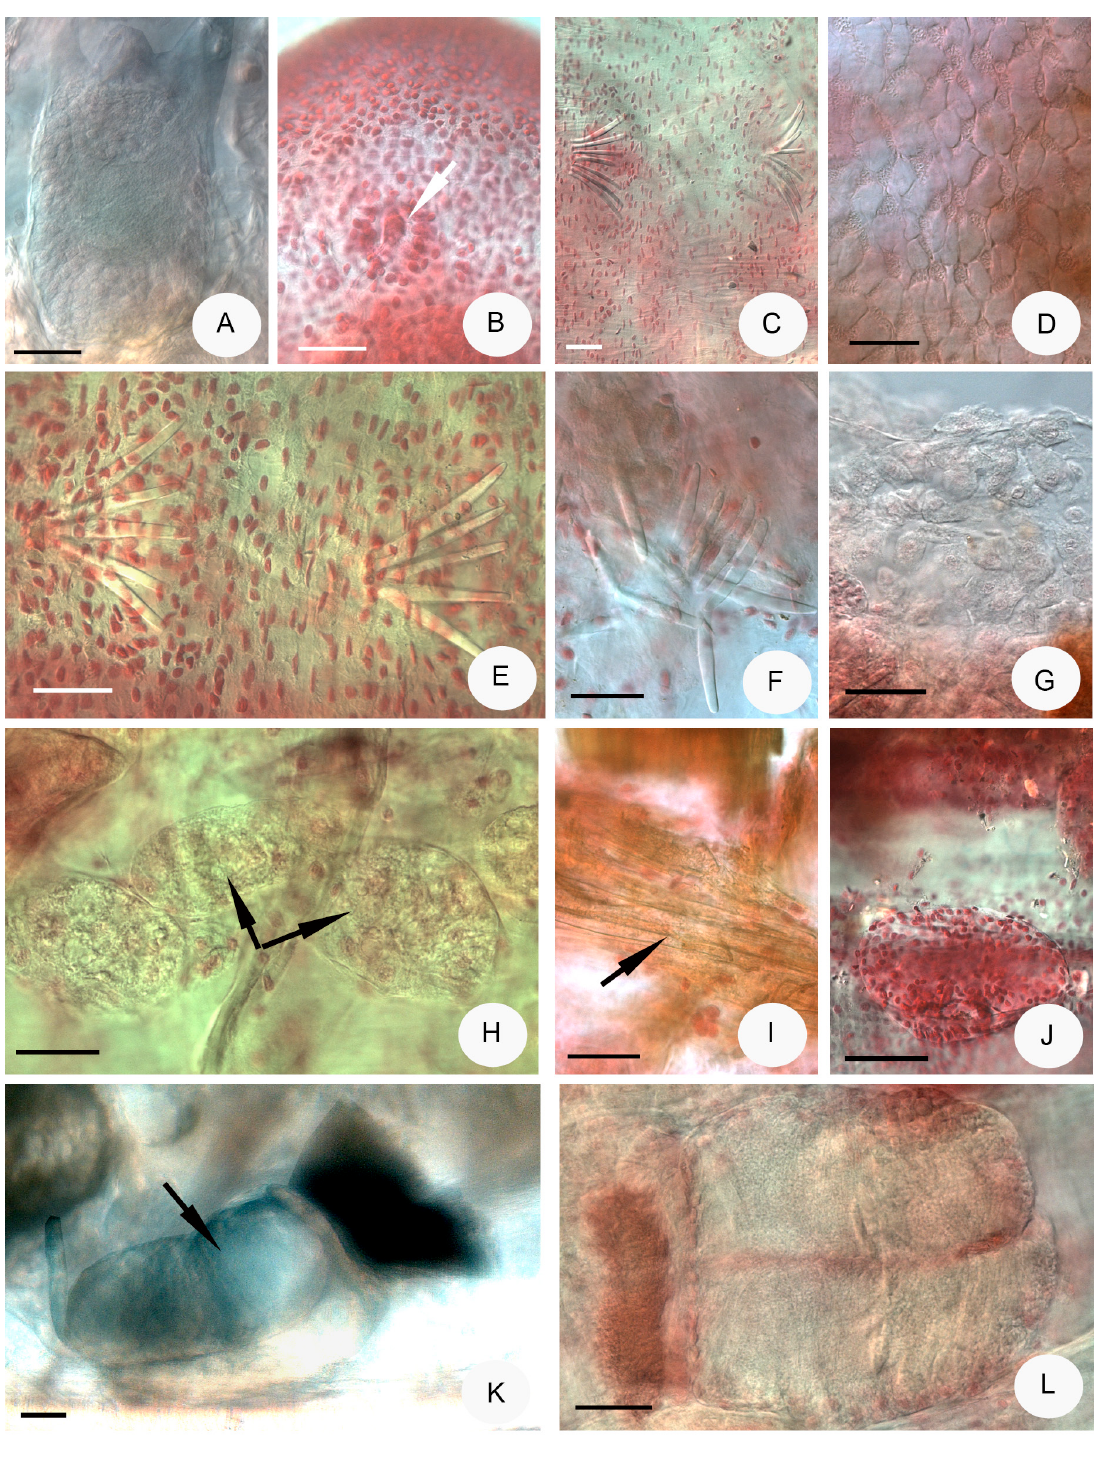
Fig. 4. Micrograph of Fridericia spelaeophila sp. nov. A . Brain. B . Head pore (marked with arrow). C . Chaetae in V–VII. D . Clitellar glands, dorsal view. E . Chaetae in VII–VIII. F . Detached chaetae in coelom. G . Coelomocytes. H . Nephridium at 7/8 (pre- and postseptale marked with arrows). I . Fragments of decaying wood in the intestine (marked with arrow). J . Male copulatory organs, lateral view. K – L . Sperm funnels. (A, K in vivo , B–J, L fixed, stained. Scale bars: 50 μm. B, G from holotype, K from DNA